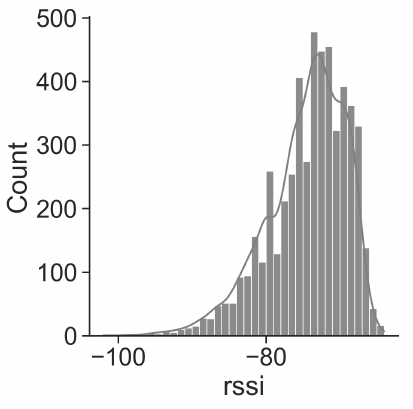
Figure 10. Cumulative distribution of beacon’s RSS for T 8 .